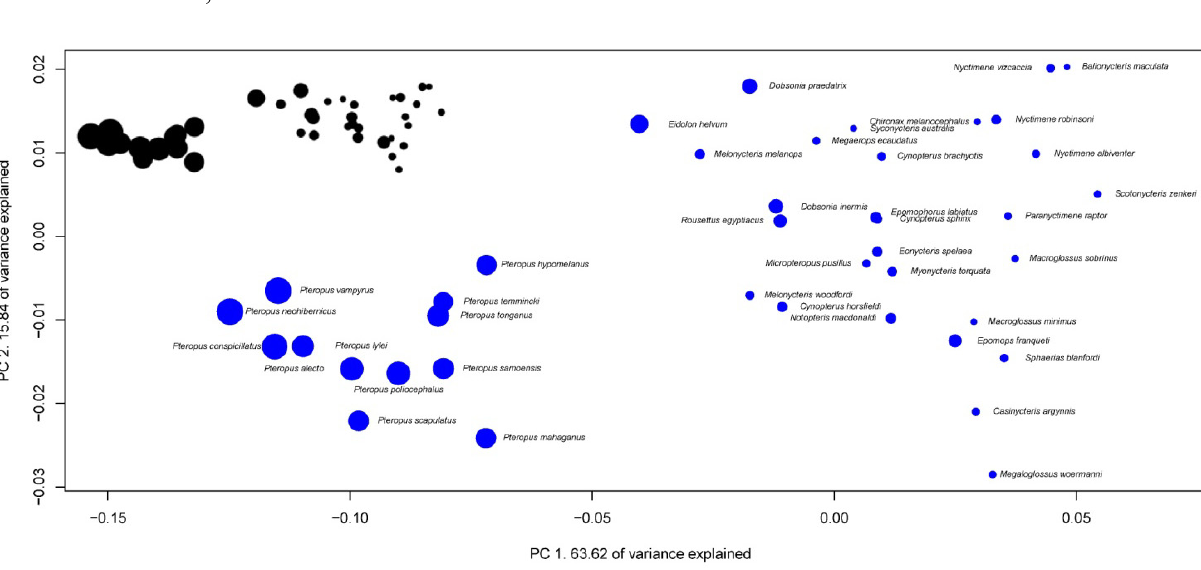
Figure 6. Phylogenetic Principal Component Analysis of Pteropodidaes’ brain structure proportions. Regression on independent contrasts of logged absolute brain size onto independent contrasts of position on PC1: Multiple R -squared: 0.485, F -statistic: 36.73 on 1 and 39 DF, P = 4.272 × 10 − 7 ; PC2: Multiple R -squared: 0.0036, F -statistic: 0.1427 on 1 and 39 DF, P =